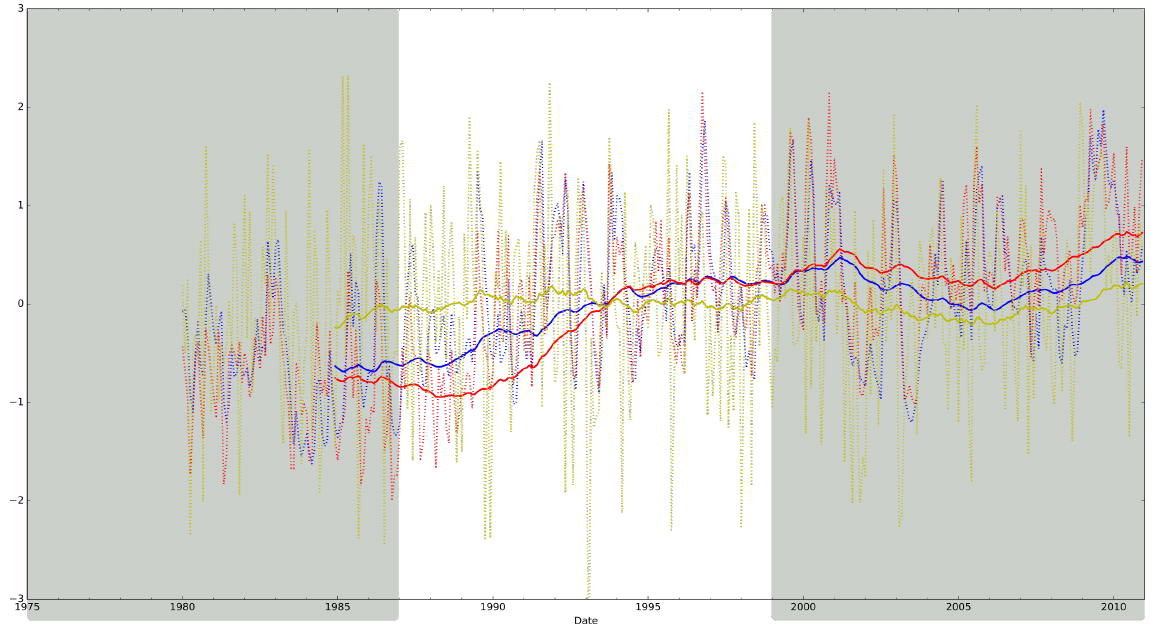
Figure 7. Average values (dotted lines) for the SGI (blue), SPI1 (yellow) and SRSI (red) and their 5-year-running means (solid lines) for the Murdurchbruchstal